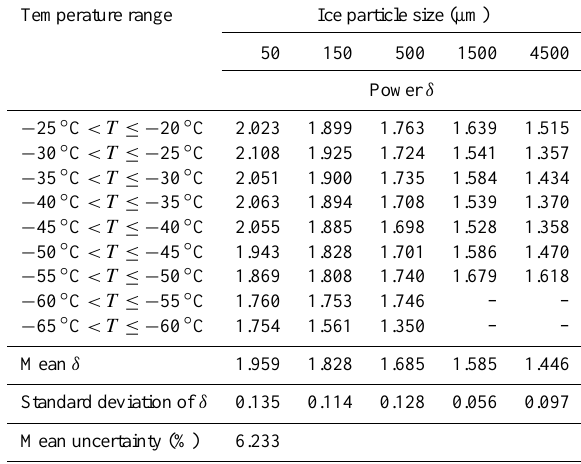
Table 5. Uncertainty estimates for area-dimension power δ for syn- optic cirrus clouds.